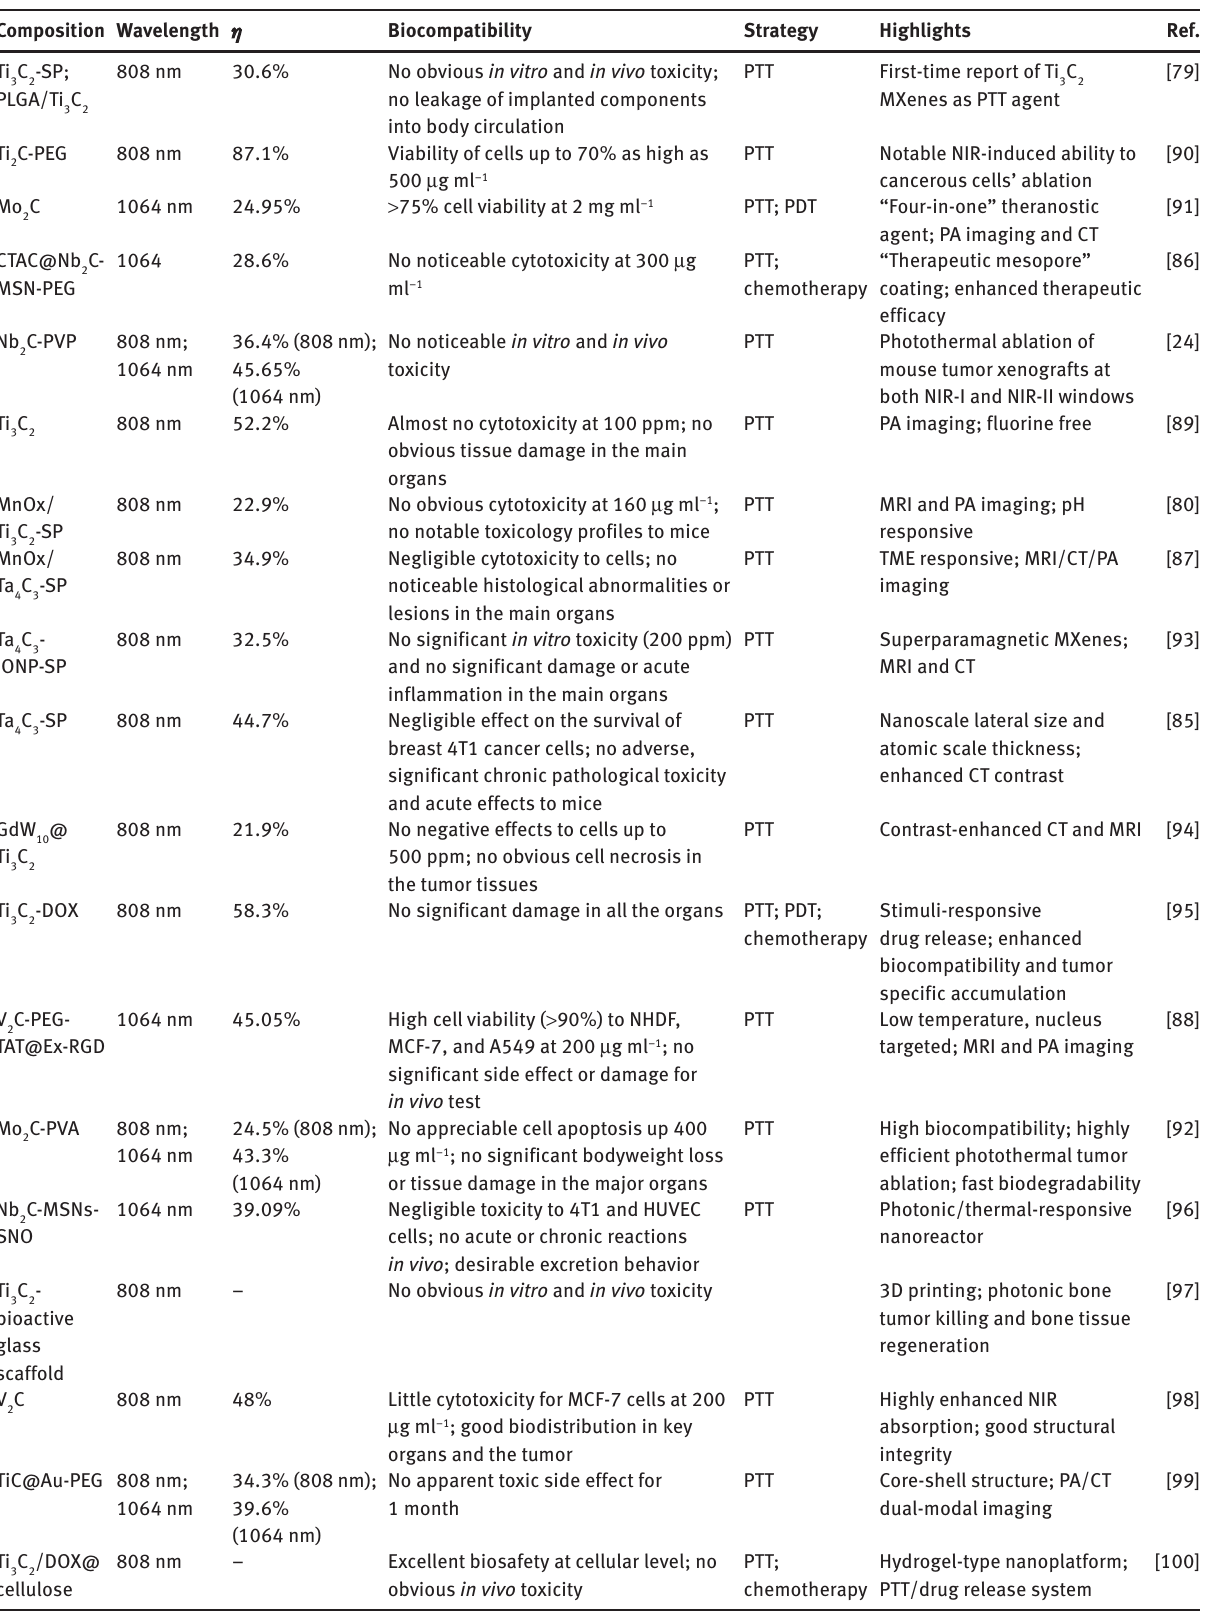
Table 1: Recent progress in MXenes with different composition, wavelength, biocompatibility, photothermal conversion efficiency ( η ), and highlights of